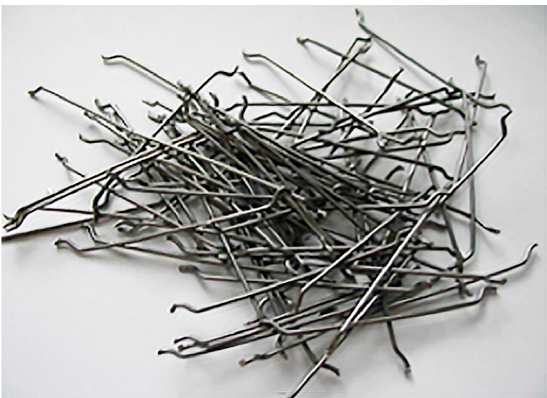
Figure 2. Steel fiber (scale 1:1).